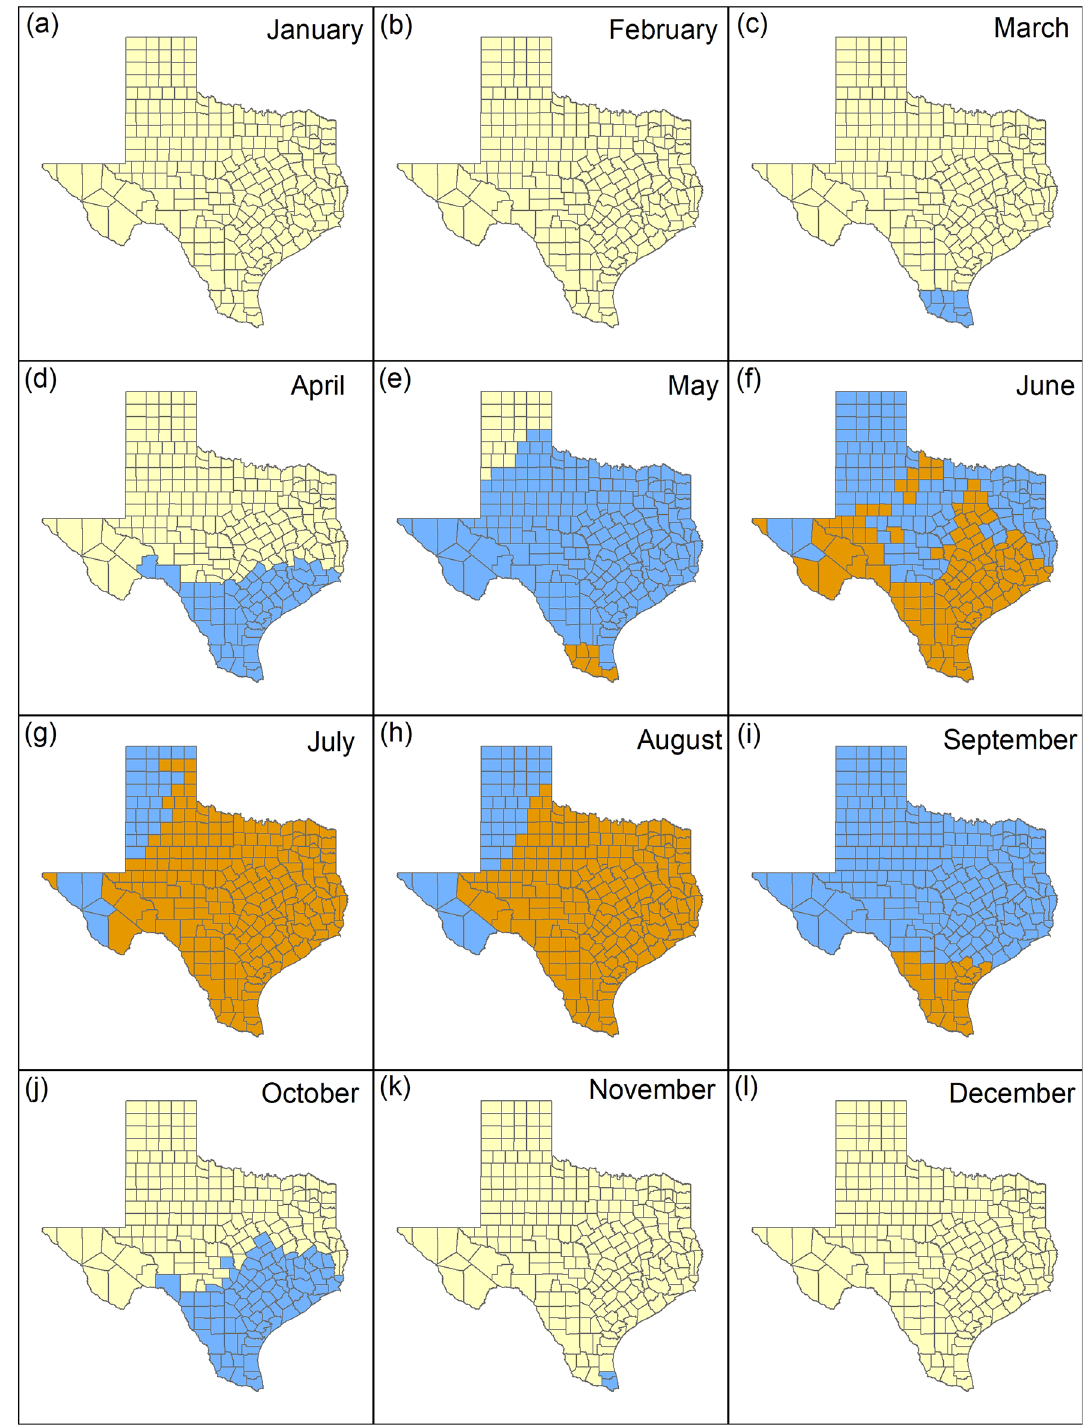
Figure 4. Monthly mean temperature (°C) from 1990 to 2019 for Texas aggregated by county. Yellow counties represent areas where temperatures are below the maximum clear ambient temperature in which deer can be detected (≤ 20 °C), blue counties represent areas where temperatures are below the maximum cloudy ambient temperature in which deer can be detected (≤ 27 °C), and orange counties represent areas where temperatures are above the maximum ambient temperatures for deer detection (> 27